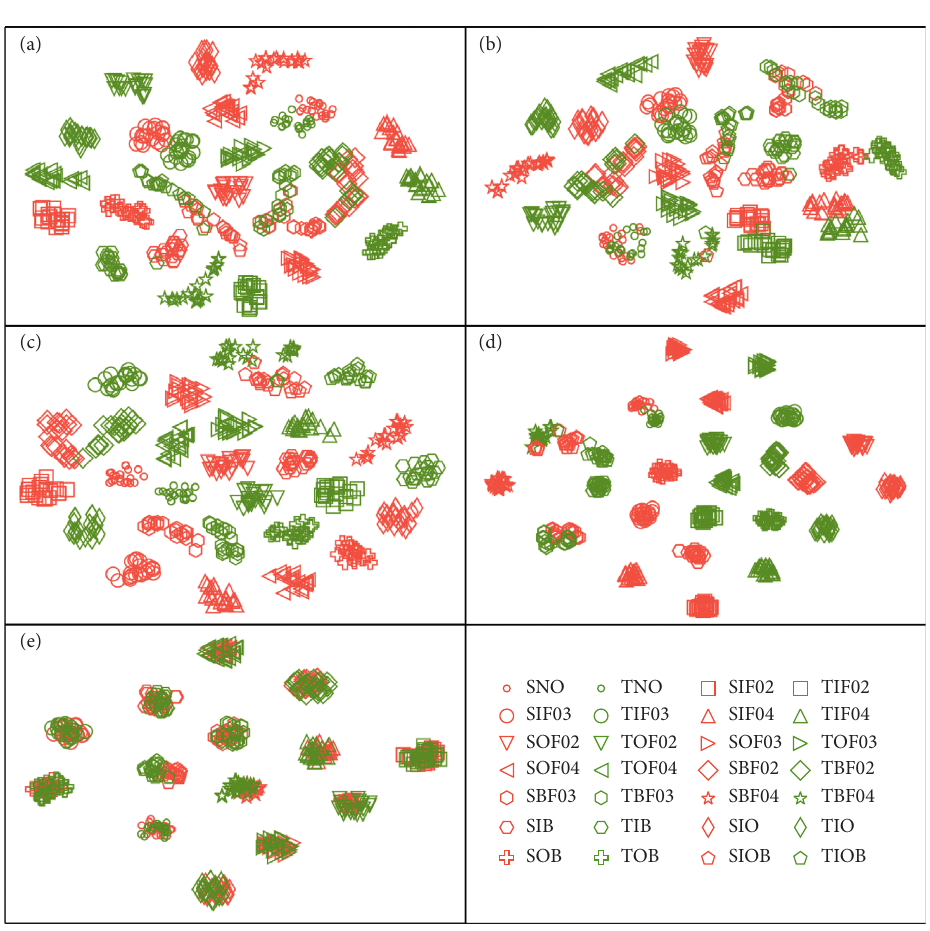
Figure 10: Visualization of transferable features. (a) TCA. (b) JDA. (c) CORAL. (d) ResNet-18. (e)